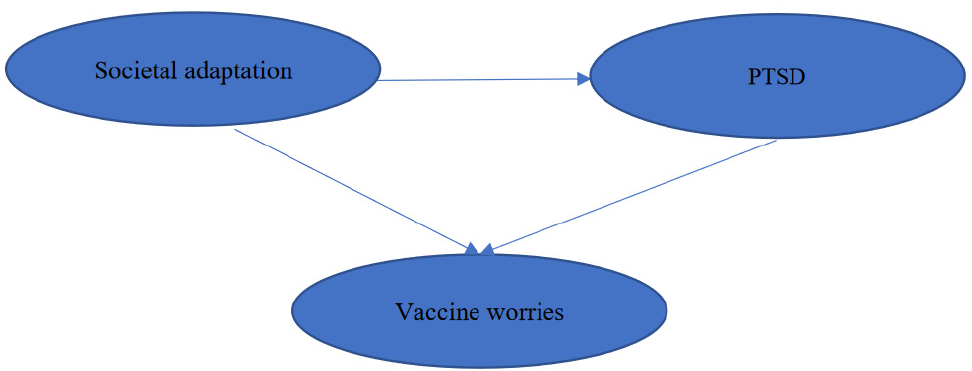
Figure 1. Hypothesized model of the associations among societal adaptation, PTSD and vaccine worries. PTSD, posttraumatic stress disorder.